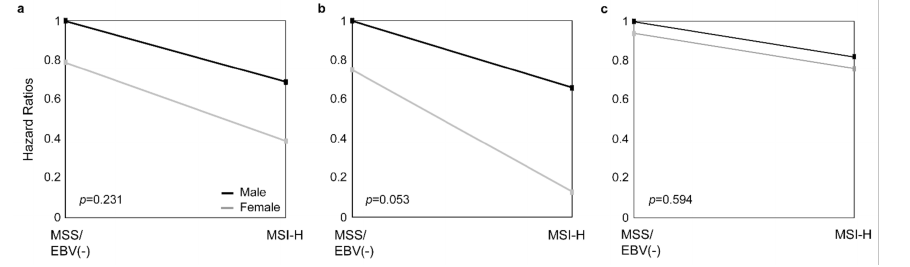
Figure 4. Interaction between sex and MSI status. The interaction between sex and the MSI status by Cox regression models is shown for all GC patients ( a ), patients treated with neoadjuvant CTx ( b ), and patients treated with surgery alone ( c